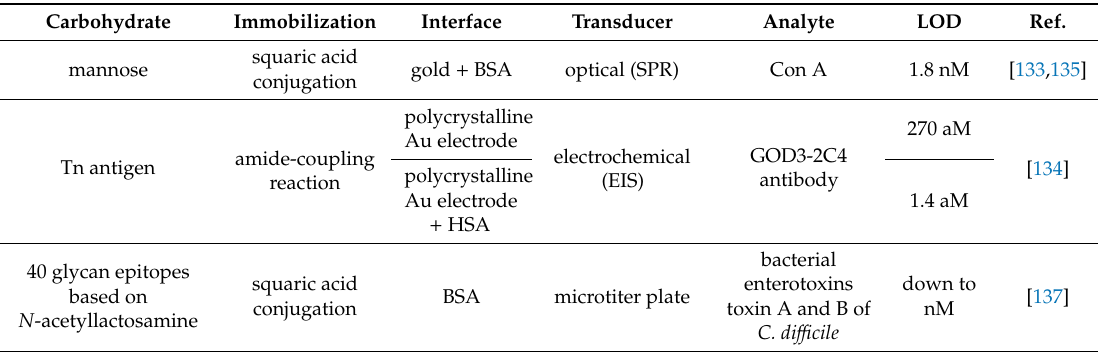
Table 6. Protein-based glycan nanobiosensors and their